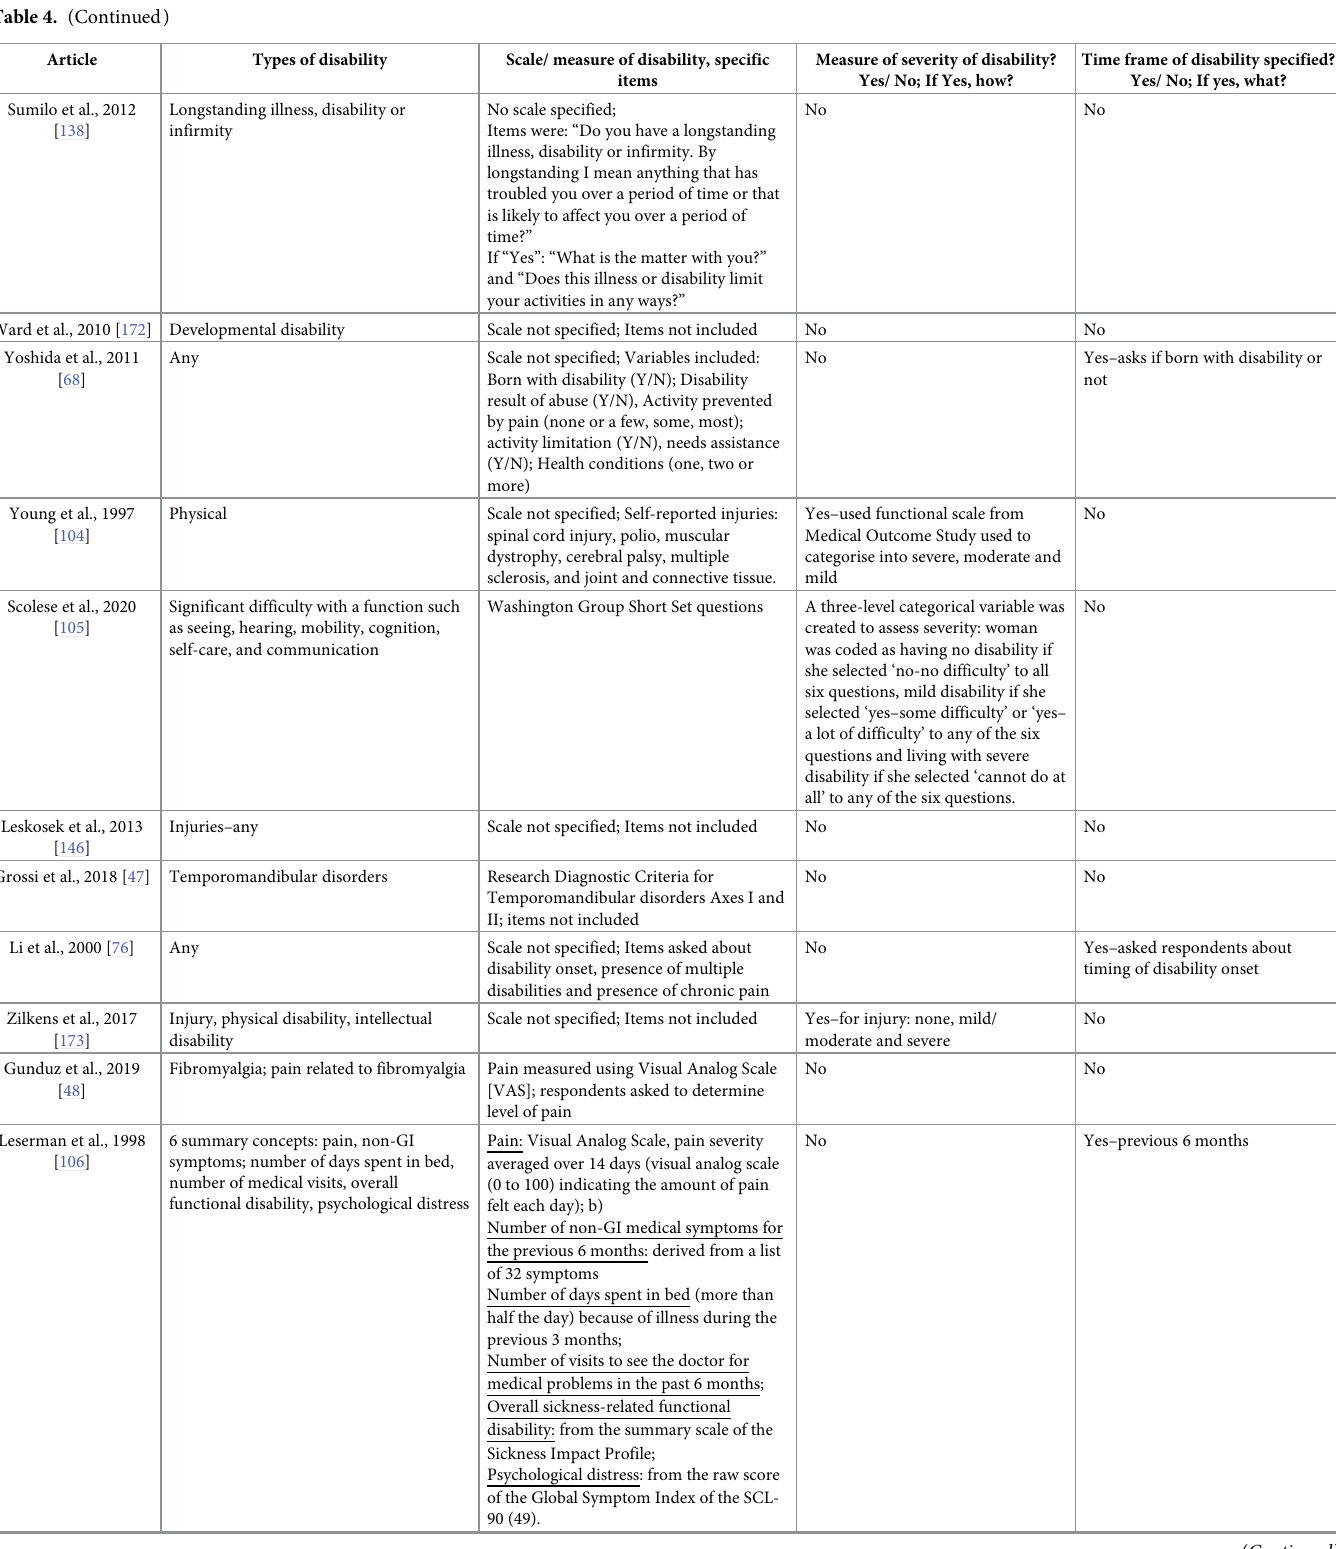
Pain: Visual Analog Scale, pain severity averaged over 14 days (visual analog scale (0 to 100) indicating the amount of pain felt each day); b) Number of non-GI medical symptoms for the previous 6 months: derived from a list of 32 symptoms Number of days spent in bed (more than half the day) because of illness during the previous 3 months; Number of visits to see the doctor for medical problems in the past 6 months; Overall sickness-related functional disability: from the summary scale of the Sickness Impact Profile; Psychological distress: from the raw score of the Global Symptom Index of the SCL- 90